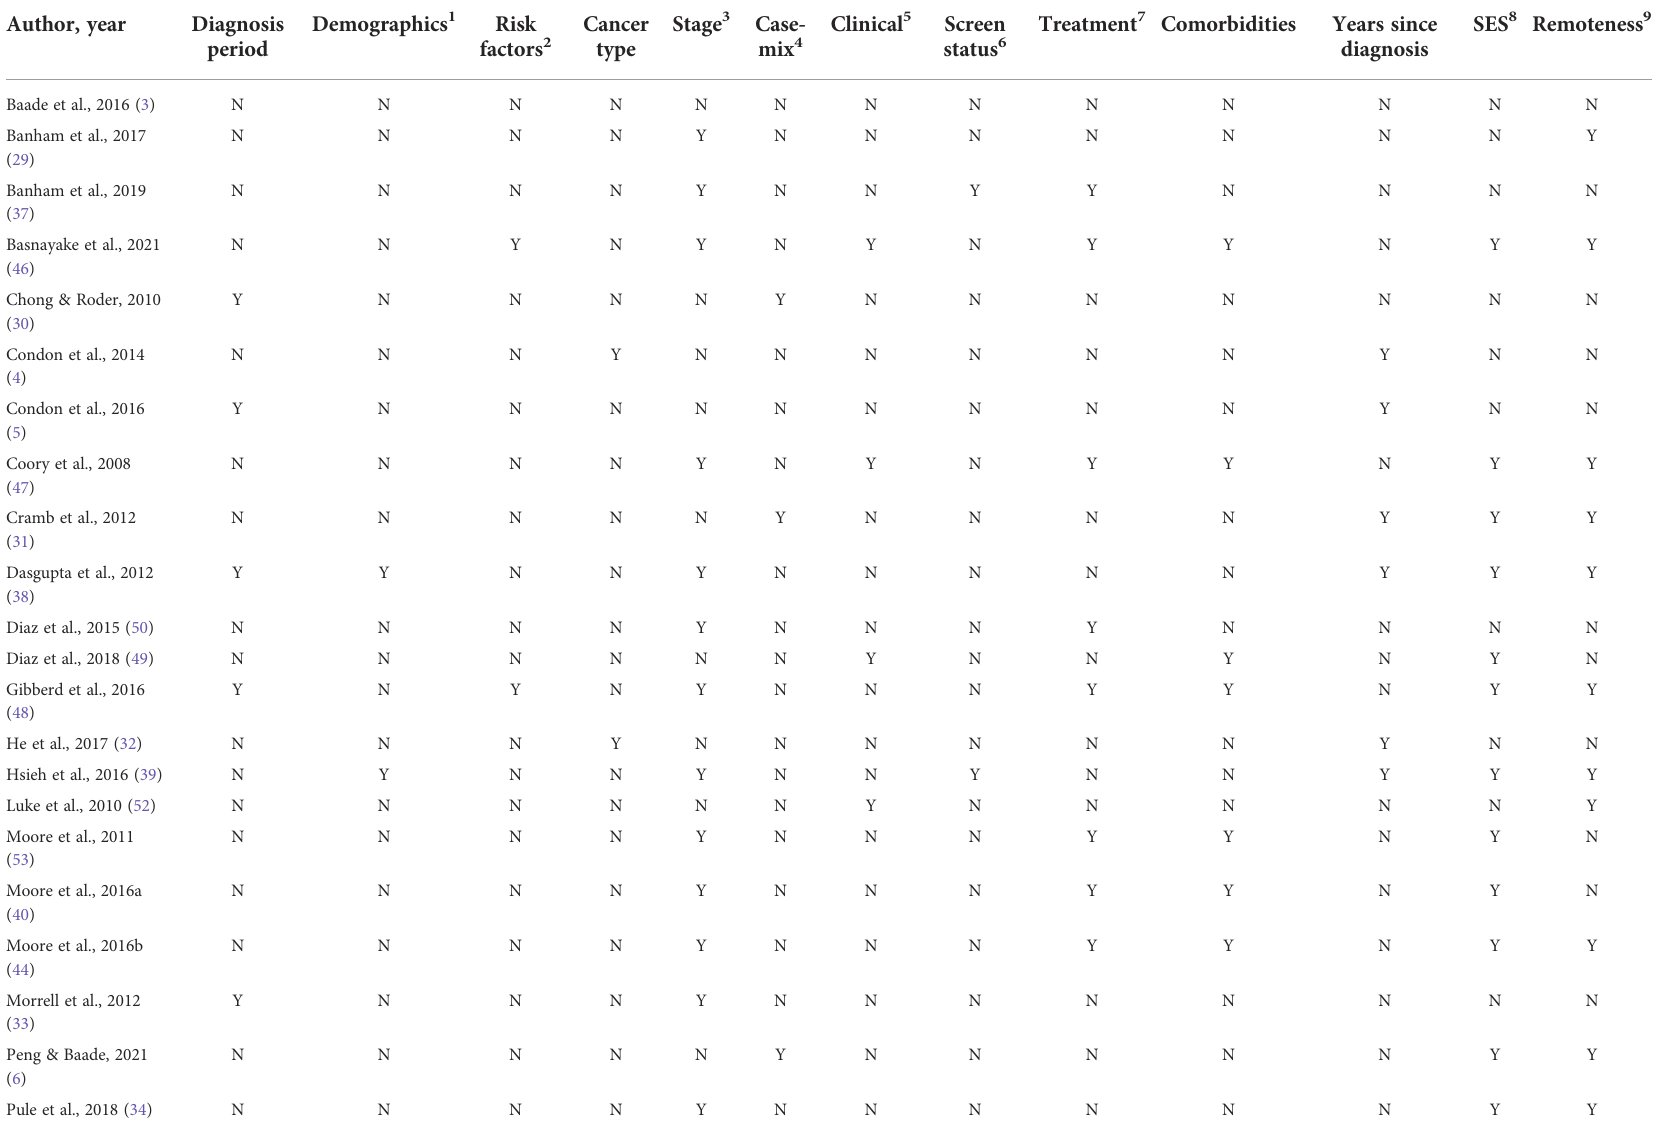
TABLE 2 Summary of included covariates other than age or sex for each of 30 included